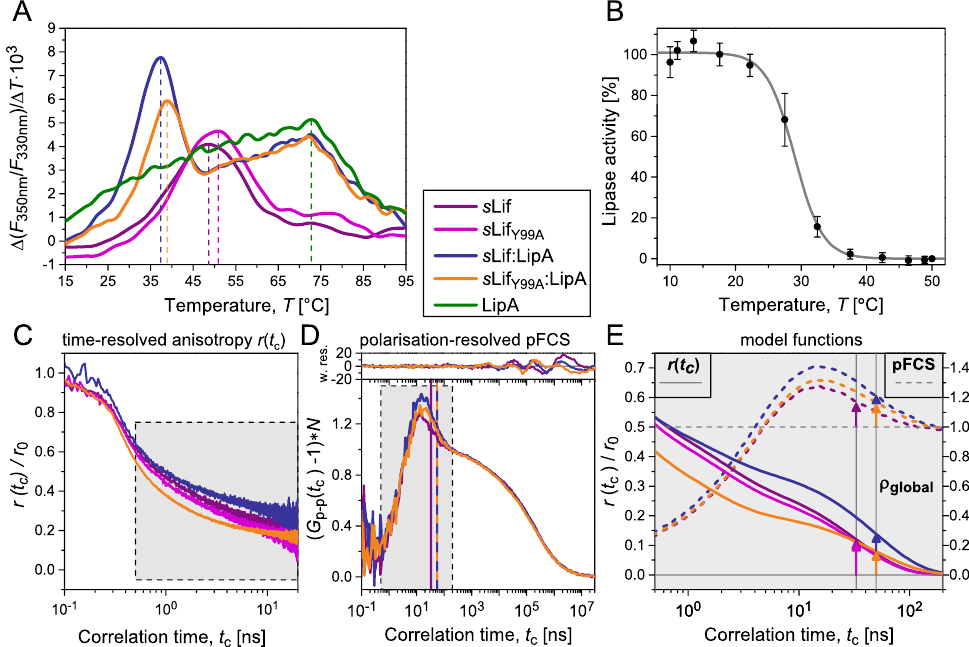
Figure 3. Effect of temperature on unfolding and activity of LipA in complex with s Lif and variant s Lif Y99A . ( A ) Melting curves of s Lif, s Lif Y99A , pre-active LipA alone and after incubation with s Lif, s Lif Y99A , MD1 and MD1 Y99A obtained by fluorescence measurement with nanoDSF. ( B ) Temperature-dependent lipase activity in a solution of sLif and LipA generated by incubation of pre-active LipA (100 nM) with s Lif (250 nM) overnight at 4 °C in TG buffer. Samples were then incubated at different temperatures (10–50 °C) for 1 h followed by measurement of the remaining lipase activity with 2 nM LipA. ( C ) Time-resolved fluorescence anisotropy decay curves r ( t c ) of free and complex sLif and s Lif Y99A . Open circles indicate experimental r ( t c ) and lines indicate model r ( t c ) (Eq. S2b, results see Table S4), dashed lines indicate complex. Further details see main text. ( D ) Polarization-resolved full-FCS of labelled s Lif using the p-p cross-correlation curves G p-p ( t c ) normalised to the number of molecules in focal volume (Eq. S3) together with weighted residuals of the fits (upper plot, Eq. S4, results in Table S5). The global rotation correlation time ρ global of s Lif is similar to the one obtained by anisotropy measurement (32 ± 3 ns, indicated by vertical line). The global rotation correlation times of s Lif:LipA and s Lif Y99A :LipA are similar (50 ± 3 ns, vertical line). ( E ) Joint analysis of the anisotropy order parameters (solid lines, see shaded area in C ) and normalized pFCS amplitudes (dashed lines, see shaded area in D ) by displaying the model functions of the fits. The global rotational correlation times are depicted as vertical lines. The corresponding amplitudes are highlighted by arrows. For further details see main